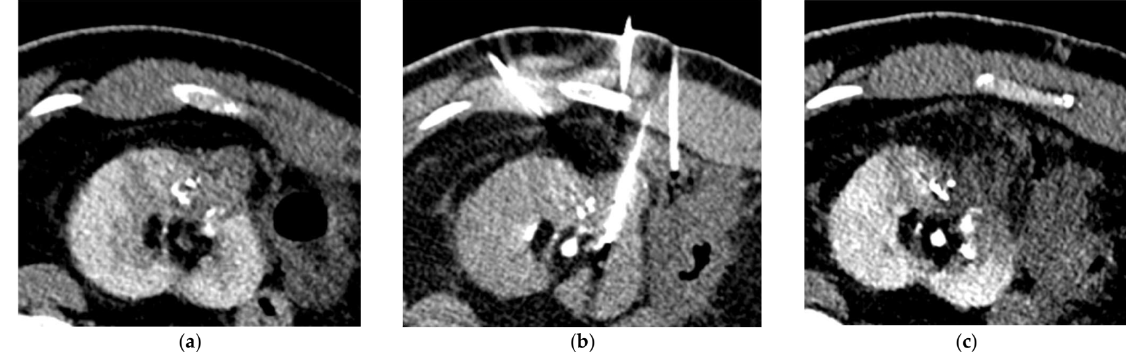
Figure 4. CT-guided percutaneous cryoablation procedure of a renal cell carcinoma of the left kidney performed after selective arterial embolization using NBCA/Lipiodol ® mixture. ( a ) Enhanced CT-scan for trajectory planification showing a complete devascularization of the tumor with lipiodol uptake. Note that the left colon is really close to the kidney. ( b ) CT acquisition showing the hydrodissection technique with needle placement for injection of dextrose solution to repel the colon and protect it. ( c ) Unenhanced control CT-scan post-ablation showing the optimal coverage of the tumor without any immediate